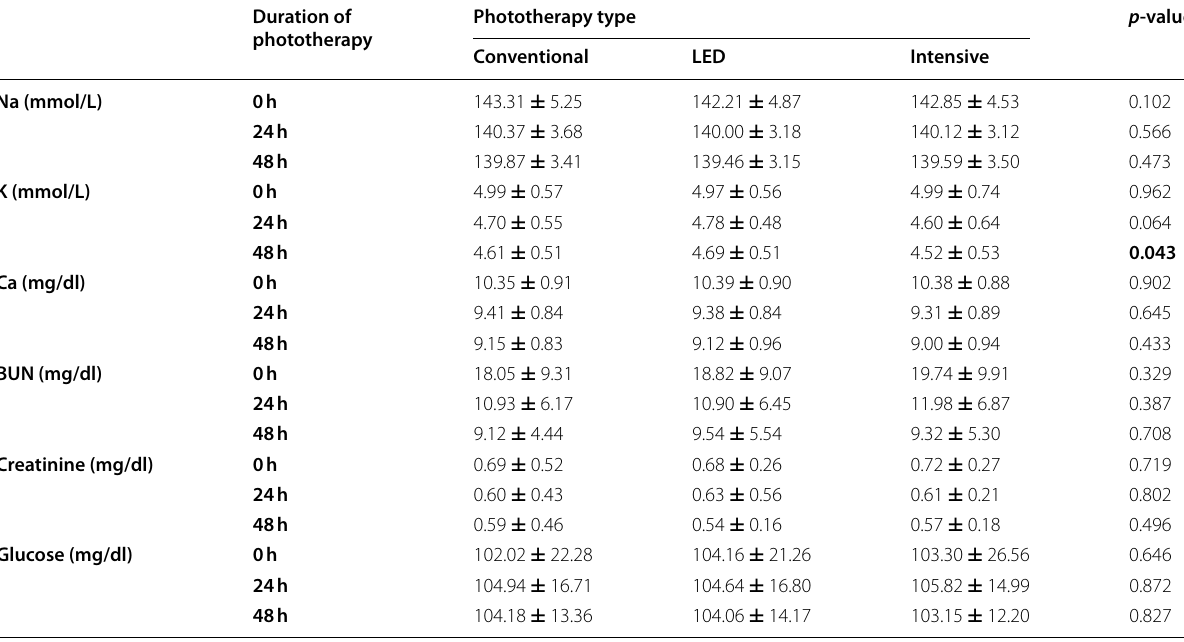
Data is presented as mean